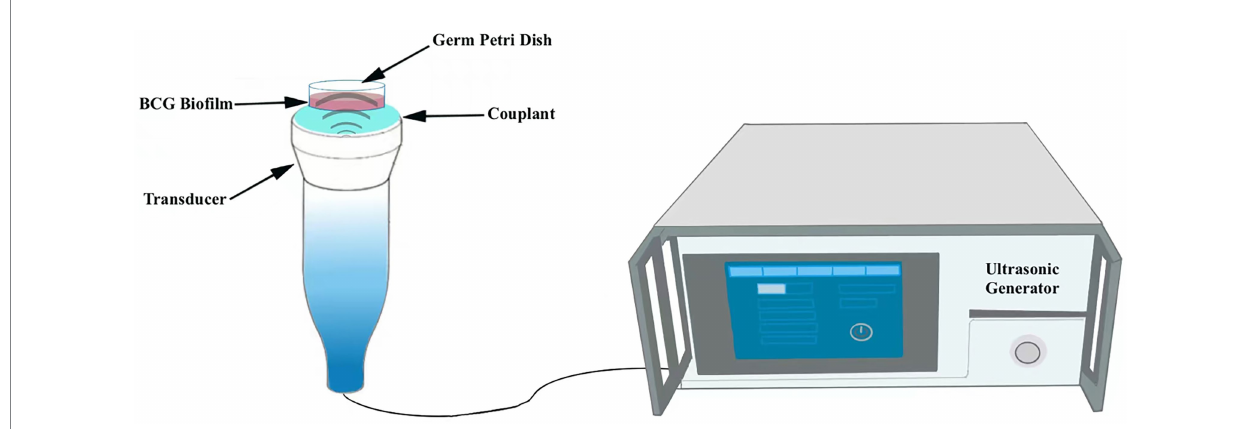
FIGURE 2 Schematic diagram of the ultrasound irradiation process. The germ culture dish is placed upright in the